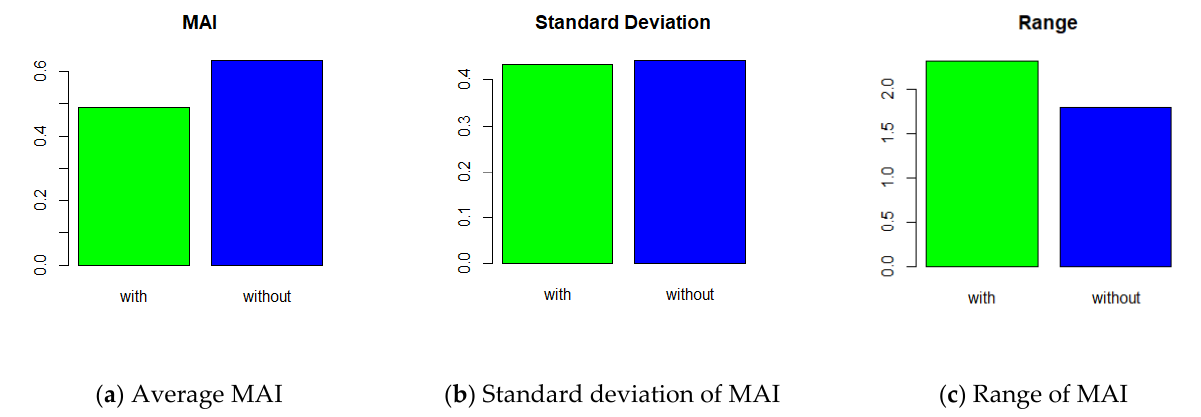
Figure 11. FWS with and without feature-weighted distance.